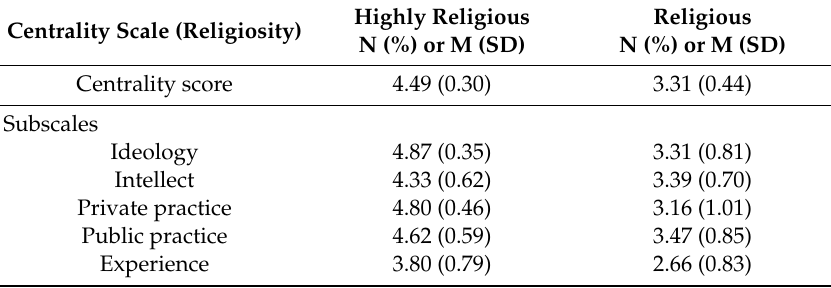
Table 2. Centrality of Religiosity Scale (CRS) of the sample.